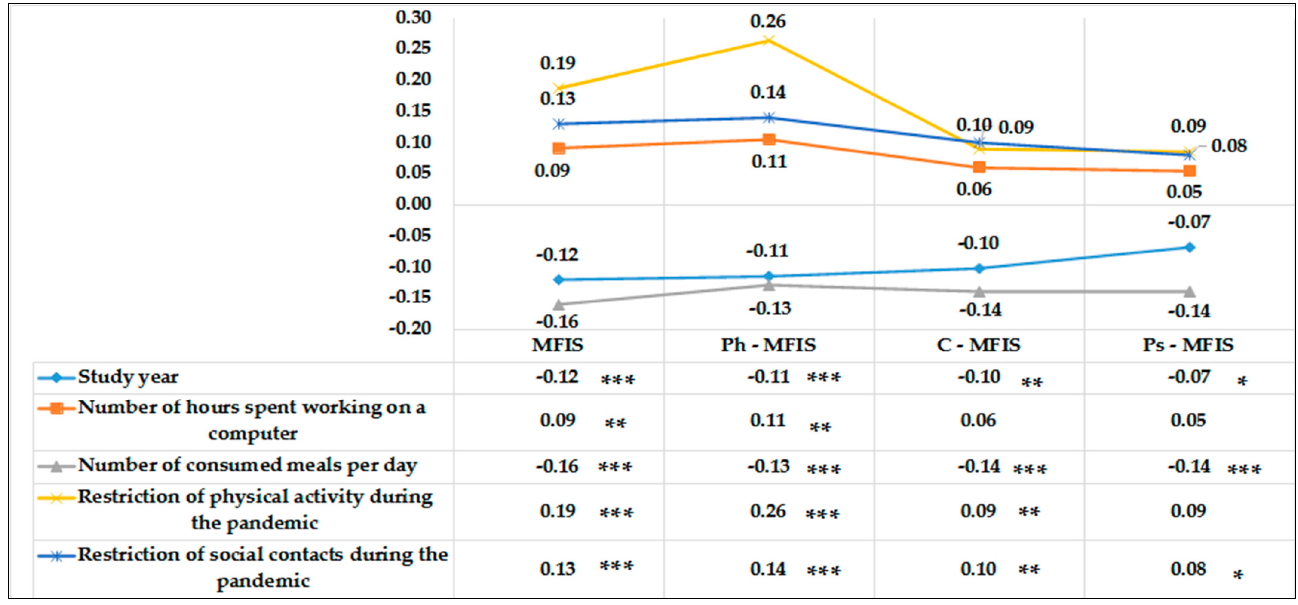
Figure 1. Correlation relationships between both the selected socio ‐ demographic and lifestyle factors and the impact of fatigue on health in general, physical, cognitive, and psychosocial terms. Statistically significant: * p < 0.05; ** p < 0.00; *** p < 0.001.